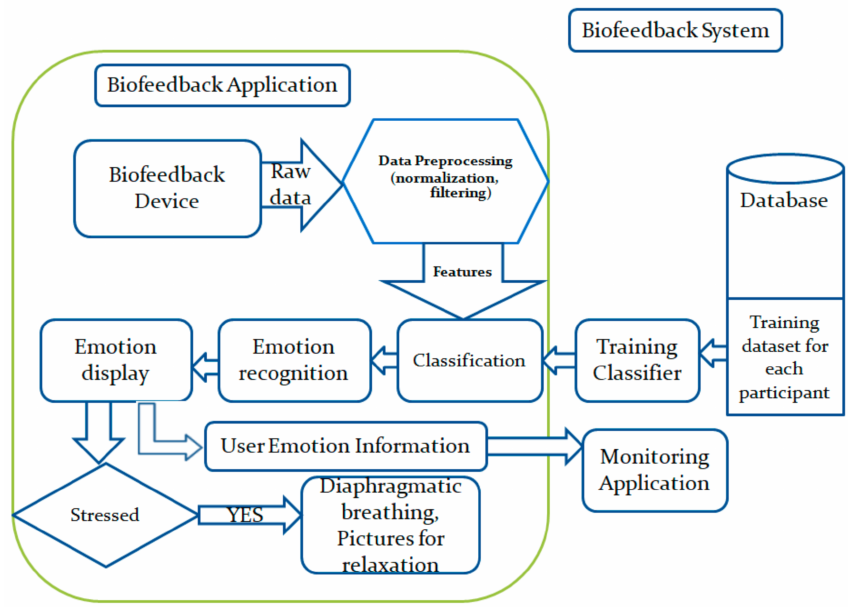
Figure 2. The biofeedback